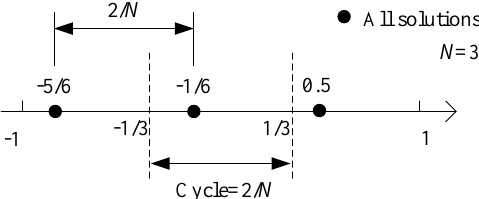
Figure 2. The cyclic solution distribution ( N = 3).